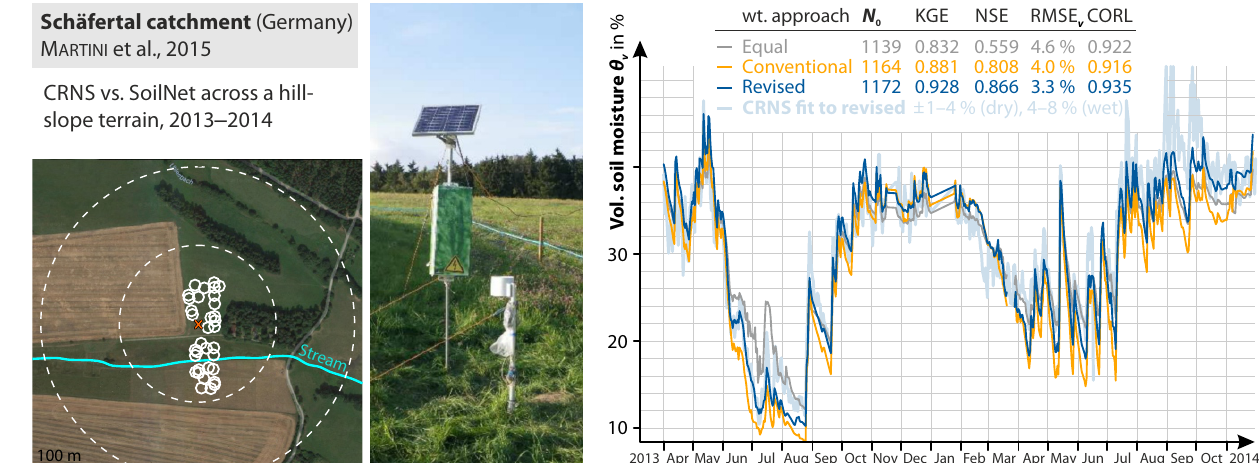
Figure 7. Time series of the CRNS soil moisture data at the SoilNet validation site in Schäfertal (Harz mountains, Germany). The average soil moisture using the conventional weighting approach (orange) exhibits poor performance against the CRNS signal (not shown). The revised approach improves four performance measures of the averaged soil moisture (blue) and the CRNS signal (light blue), although the SoilNet probes are unevenly distributed in the CRNS footprint. The uncertainty of volumetric soil moisture introduced by the insufficient coverage ranges from 1 to 8% depending on wetness